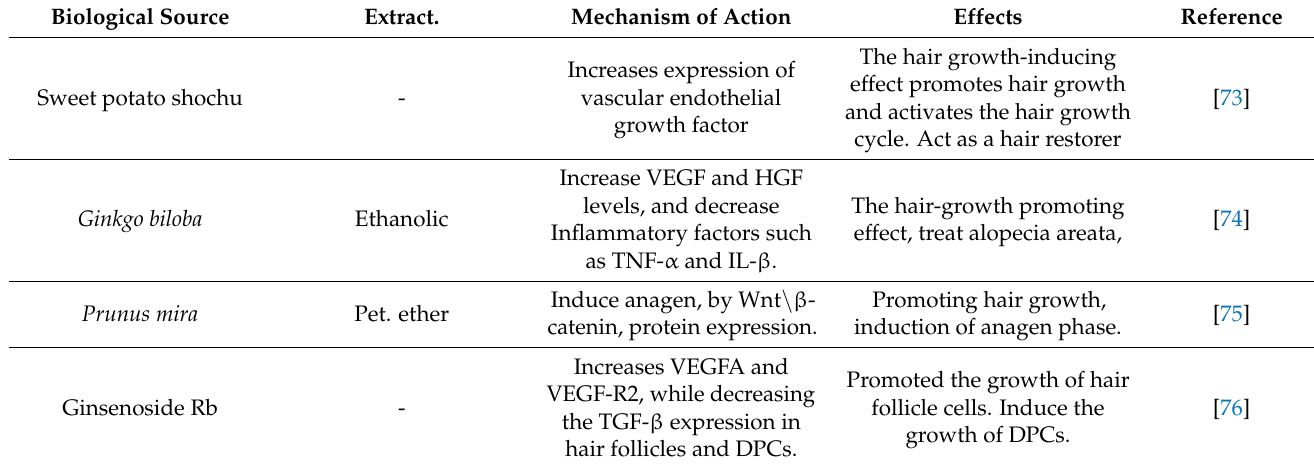
Table 3. Herbal drugs act on stimulation and inhibition by different